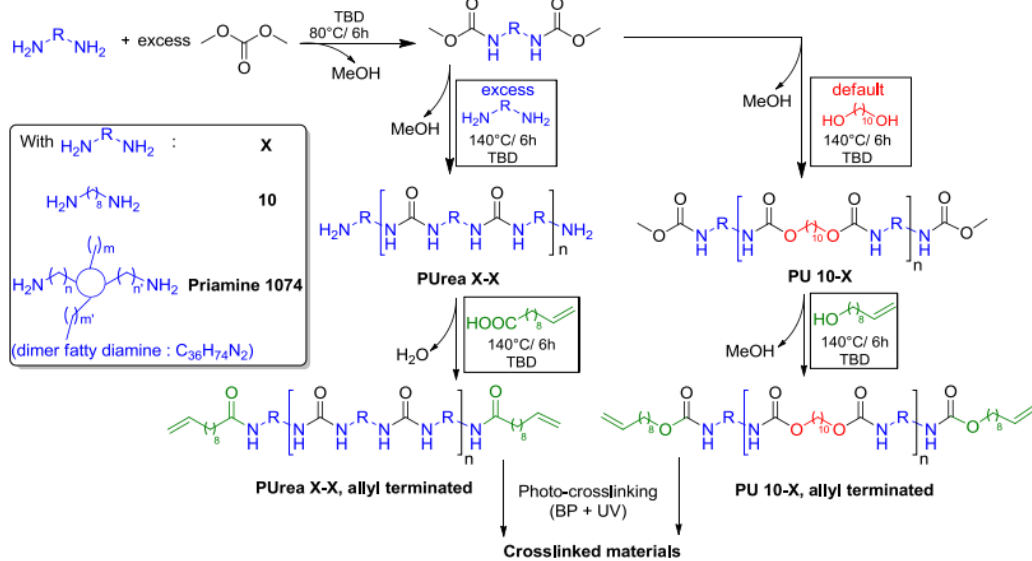
Figure 43. Synthesis of renewable allyl terminated polyurethanes and polyureas. From reference